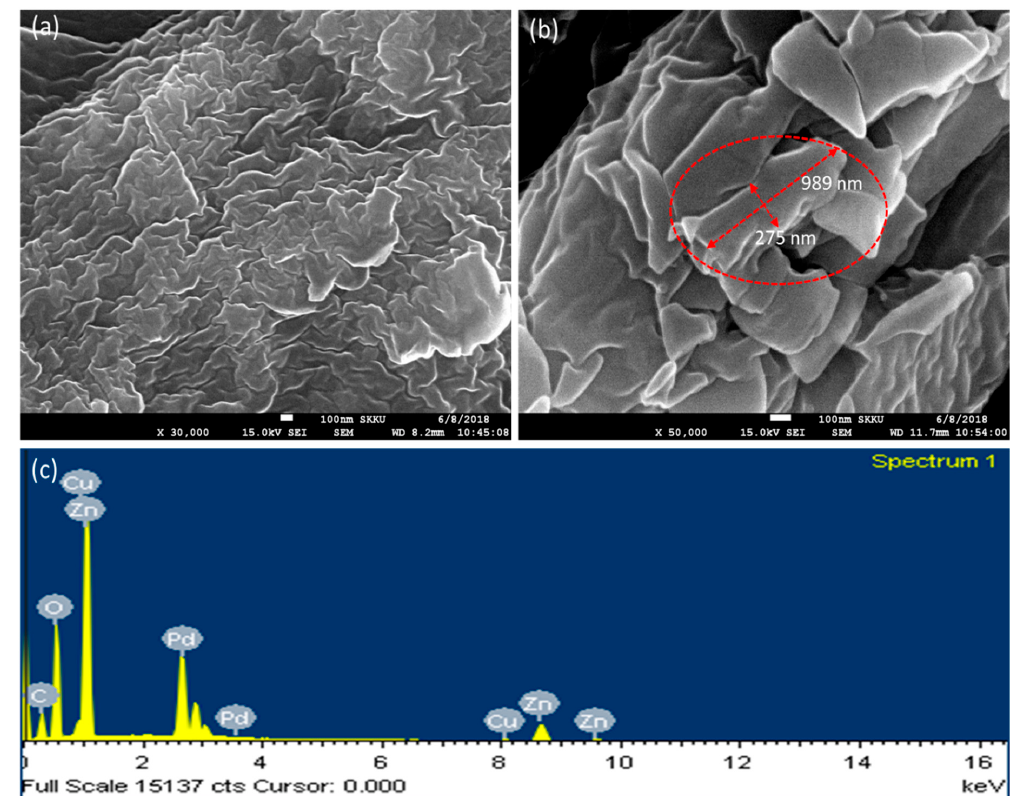
Figure 2. Field emission scanning electron microscope (FESEM) images of biosynthesized ZnO-Pd nanosheets. ( a ) Overall view of the sample. ( b ) Micrograph showing the nanosheets. ( c ) Energy-dispersive X-ray (EDX) spectrum of biosynthesized ZnO-Pd